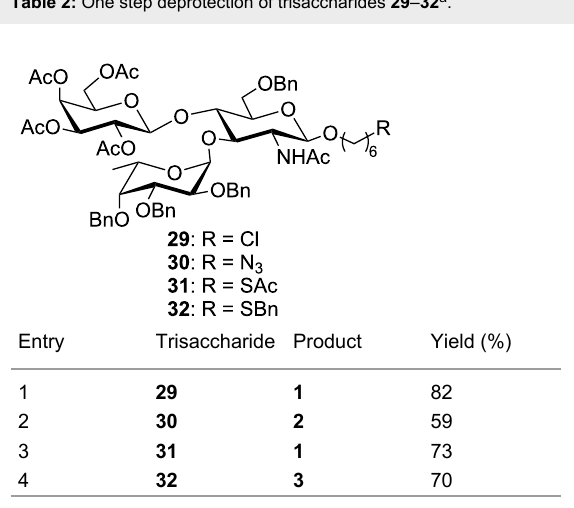
Table 2: One step deprotection of trisaccharides 29 – 32 a